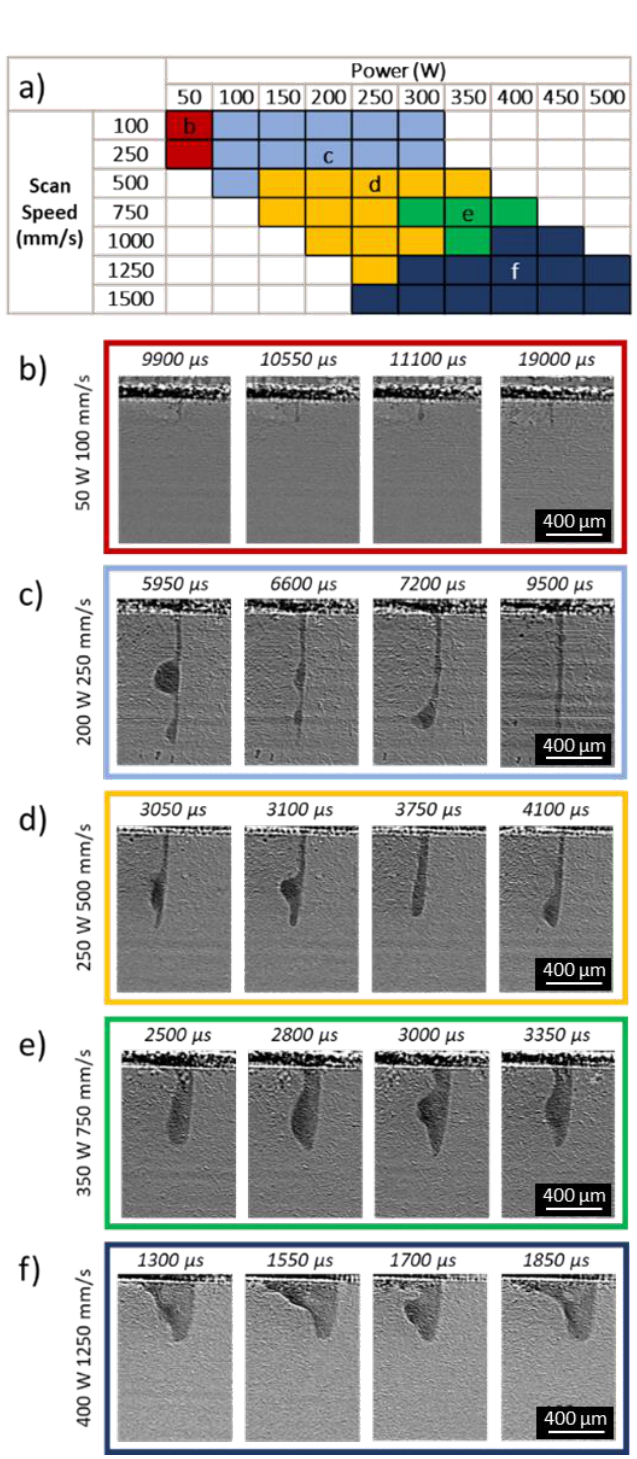
Figure 3. ( a ) Parameter matrix showing five regimes of vapor depression shape. ( b – f ) Representative in situ X-ray images for each regime: ( b ) P = 50 W, v = 100 mm/s, showing a thin, shallow vapor depression. ( c ) P = 200 W, v = 250mm/s, showing a deep thin vapor depression with large bulbous protrusions. ( d ) P = 250 W, v = 500 mm/s, showing a thin mid-depth vapor depression with a persistent oscillating protrusion to the rear. ( e ) P = 350 W, v = 750 mm/s, showing a thick mid-depth vapor depression with a persistent oscillating protrusion to the rear. ( f ) P = 400 W, v = 1250 mm/s, showing a thick mid-depth vapor depression with a trailing tail opening up to the surface.